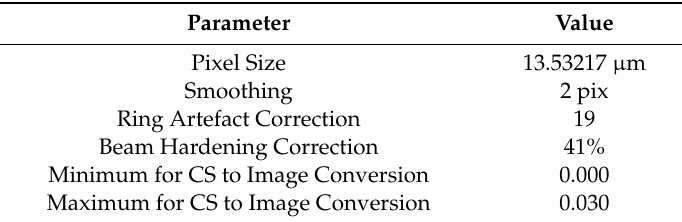
Table 10. Reconstruction parameters.